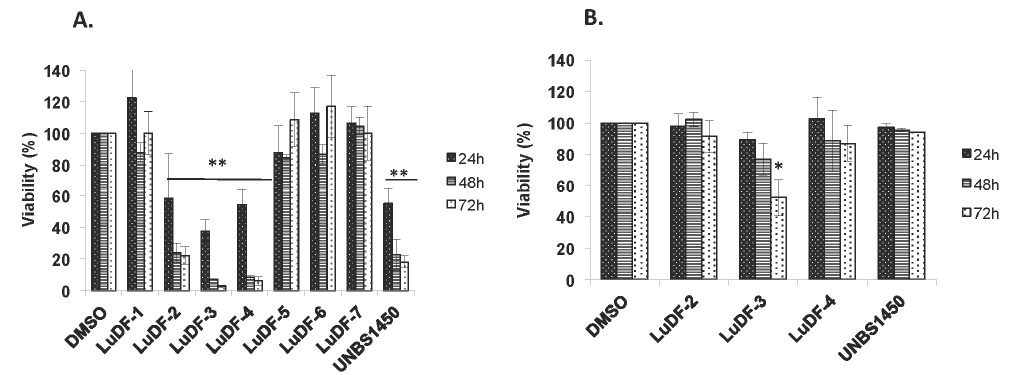
Figure 3. Viability assays by trypan blue exclusion test on K562 cells treated or not with TLC fractions (10 μ g/mL) of L. ukambensis extract for 24, 48, and 72 h ( A ); cytotoxic fractions were tested on PBMCs (peripheral blood mononuclear cells) under the same conditions ( B ). UNBS1450 was used as positive control at 0.01 µ g/mL. Results are the mean ± SD from three independent experiments. LuDF: Lantana ukambensis Dichloromethane Fraction; (DMSO): dimethyl sulfoxide.